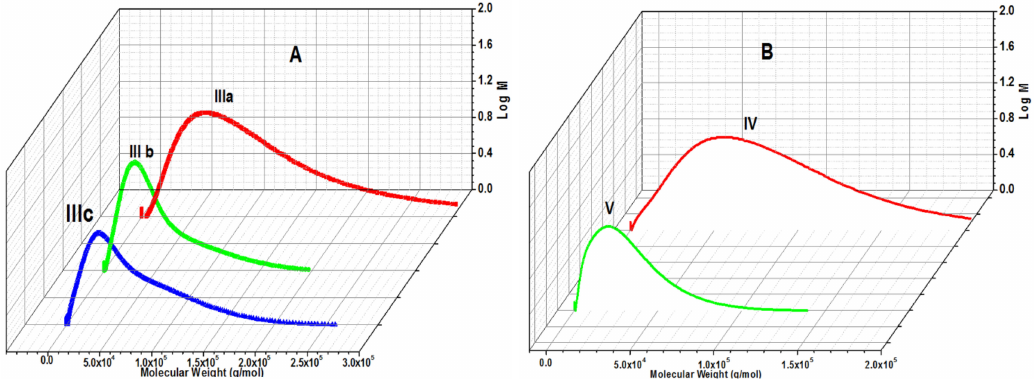
Figure 9. GPC molecular weight of copolymers; ( A ) IIIa–c ; ( B ) IV and V